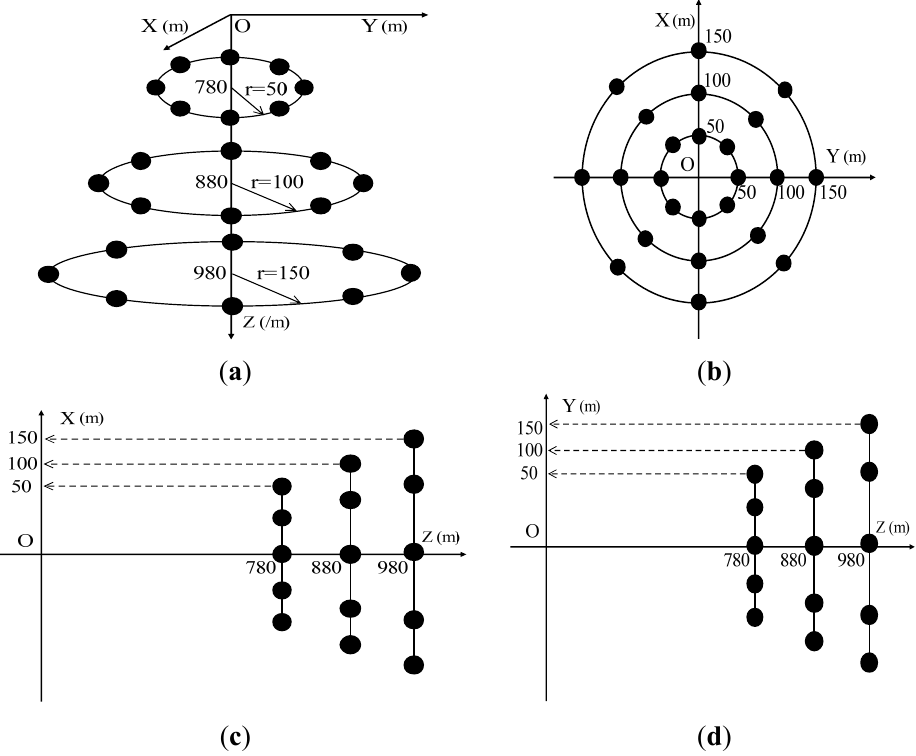
Figure 9. ( a ) Sketch of point targets. ( b ) Projection onto XY plane. ( c ) Projection onto XZ plane. ( d ) Projection onto YZ